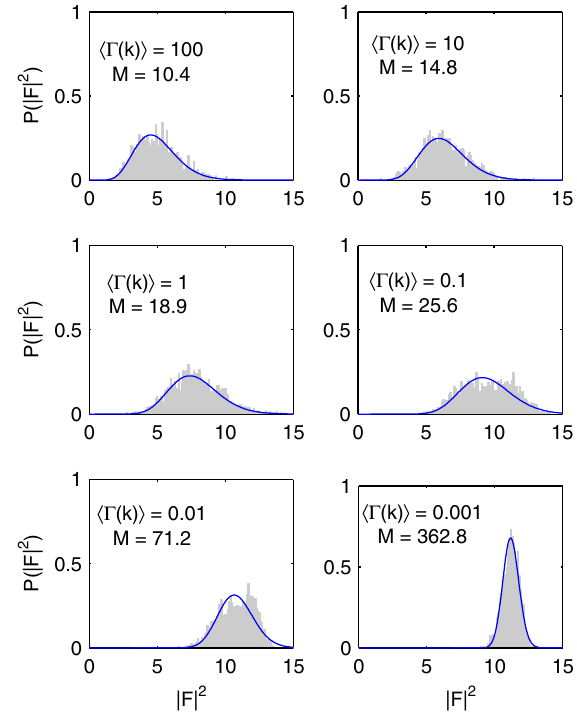
FIG. 5. Histograms of the probability density distribution, p ðj F jÞ 2 , of the normalized maximal power j F j 2 for different levels of noise. The solid blue curves represent corresponding Gamma distributions. Calculations have been performed with 1600 statistically independent simulations. The bunch and FEL parameters are given in Tables I and